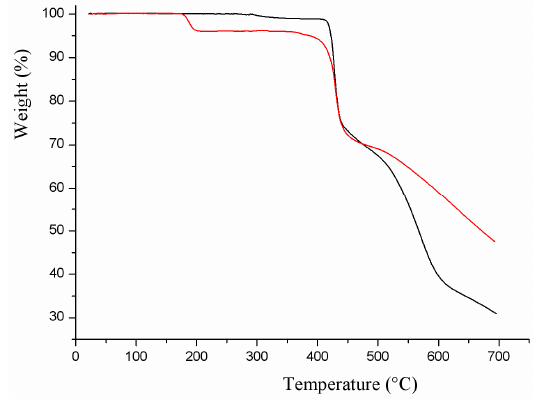
Figure 9. Thermal analysis curve of the complexes 1 and 2 .